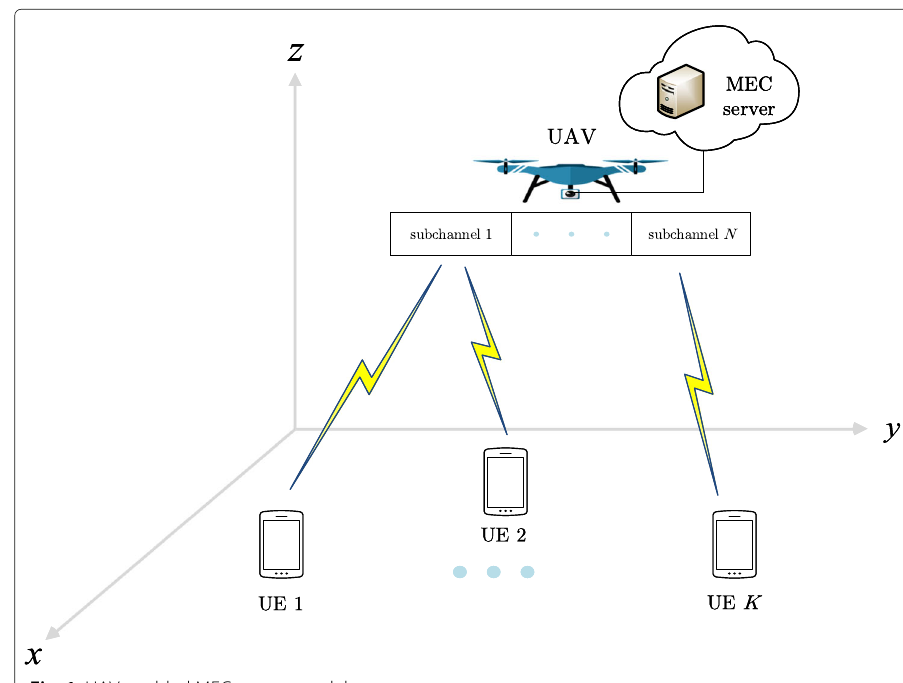
Fig. 1 UAV-enabled MEC system